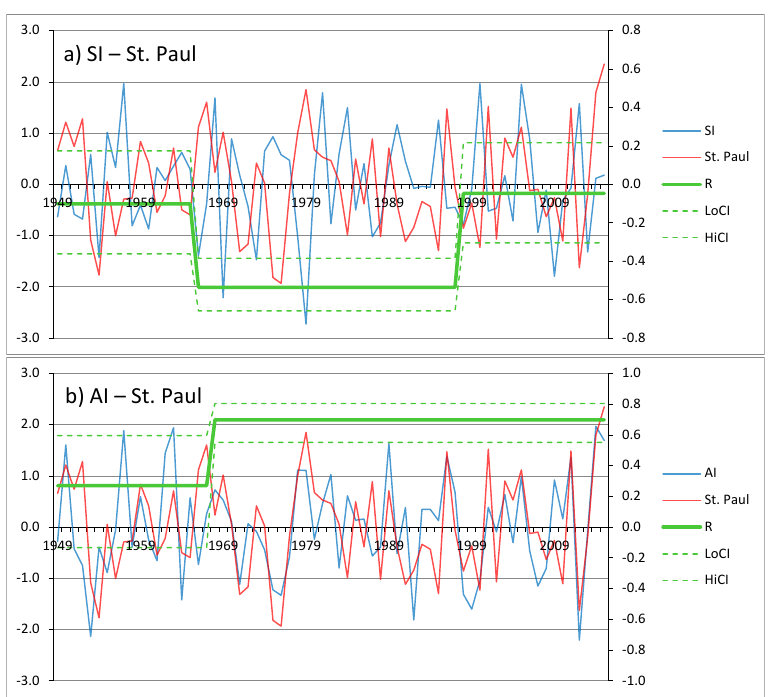
Figure 9. Regime shifts in the correlation coefficient between SAT at St. Paul and ( a ) Siberian and ( b ) Alaskan indices. The target significance level and cut-off length were set at 0.3 and 15, respectively, for the pair SI–St. Paul, and 0.1 and 15 for the pair AI–St. Paul. The change-points and their 𝑝 -values (in parentheses) are: (a) 1966 (0.13); 1998 (0.09) and (b) 1968